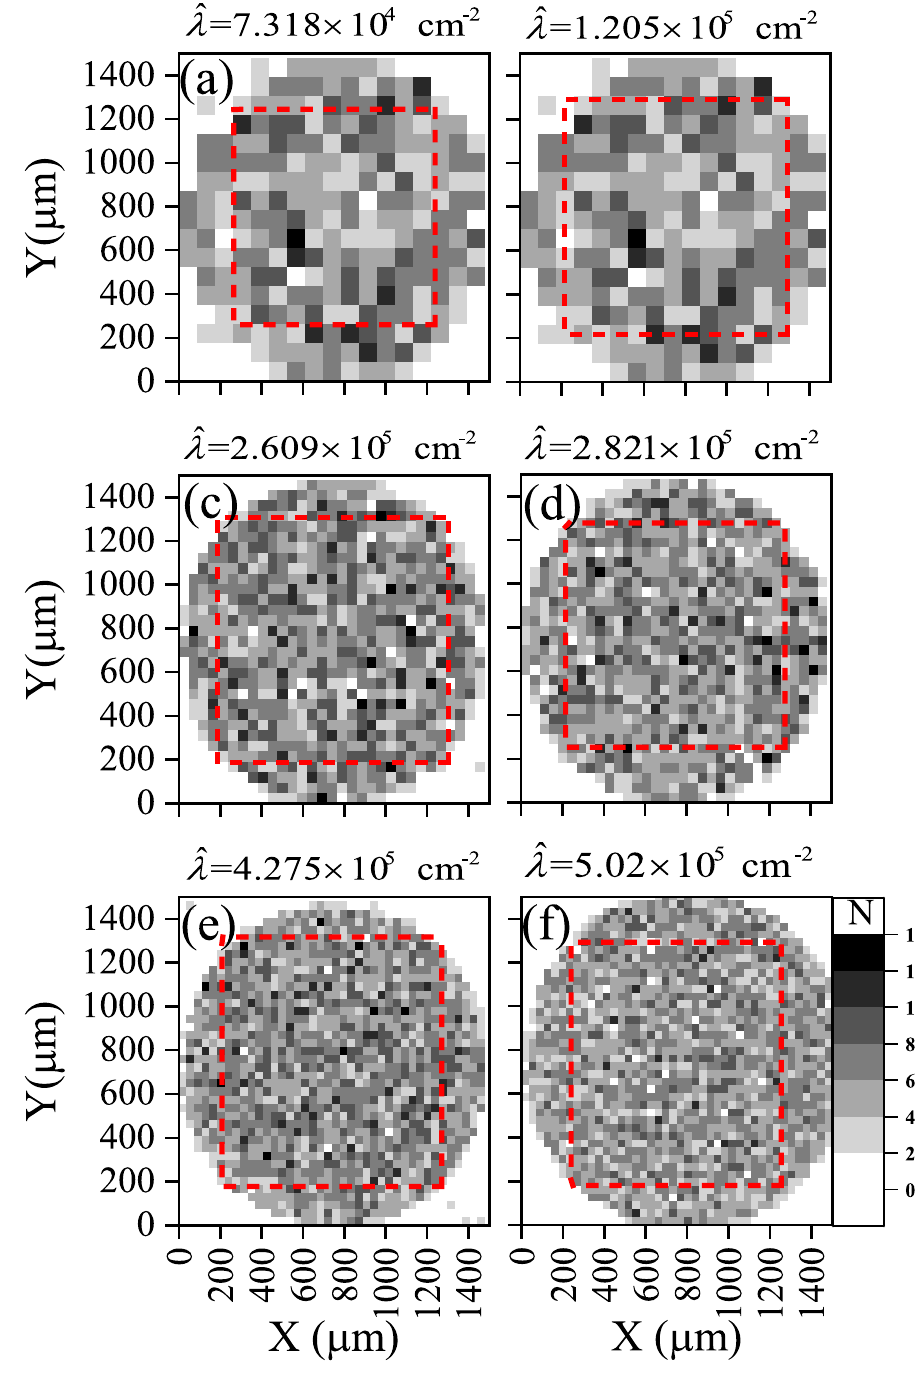
Figure 8. Constructed as in Fig. 6 for the investigated local track densities of samples a4, b4/1, c4, d4/1, e4, and f4 after being etched for 4